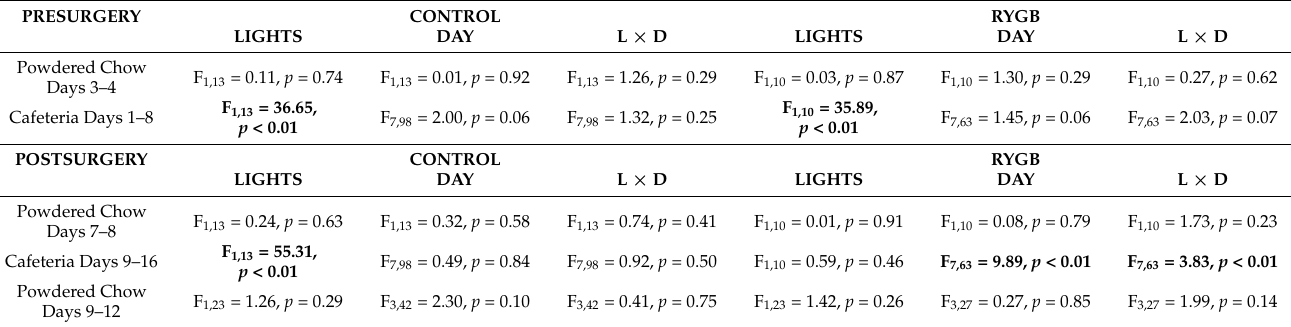
Table 19. Two-way ANOVAs Comparing Lights-On to Lights-Off Meal Eating Rate within Groups for Each Diet Condition.